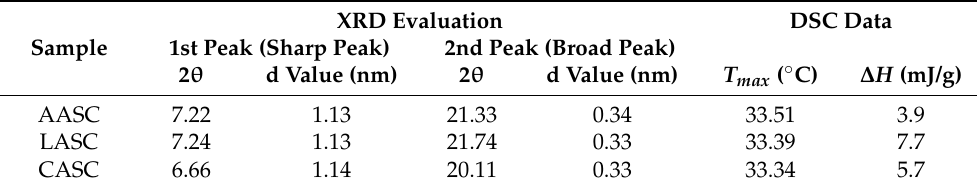
Table 3. XRD and DSC analyses of the acid soluble unicornfish ( N. reticulatus ) bone collagen.